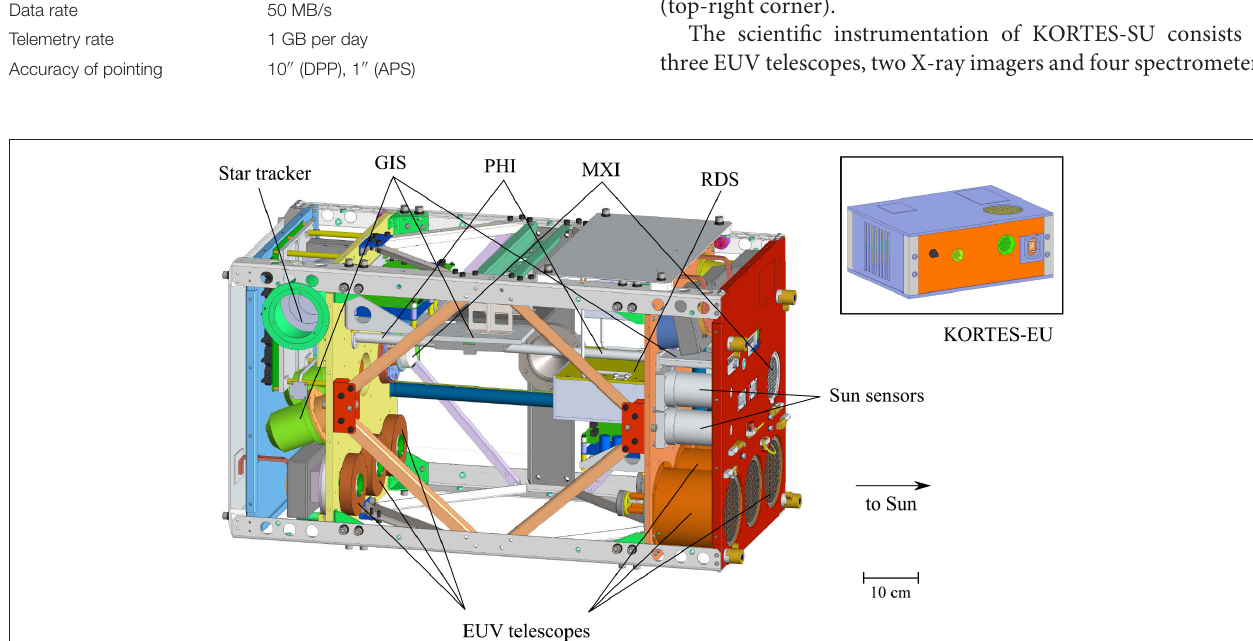
FIGURE 1 | A general view of the KORTES-SU assembly. The SU unit is to be mounted on a dual-axis pointing platform on the service module of the ISS Russian segment. Top-right corner: the KORTES-EU unit (proportions are preserved). The EU unit will be placed inside the sealed compartment of the ISS Russian